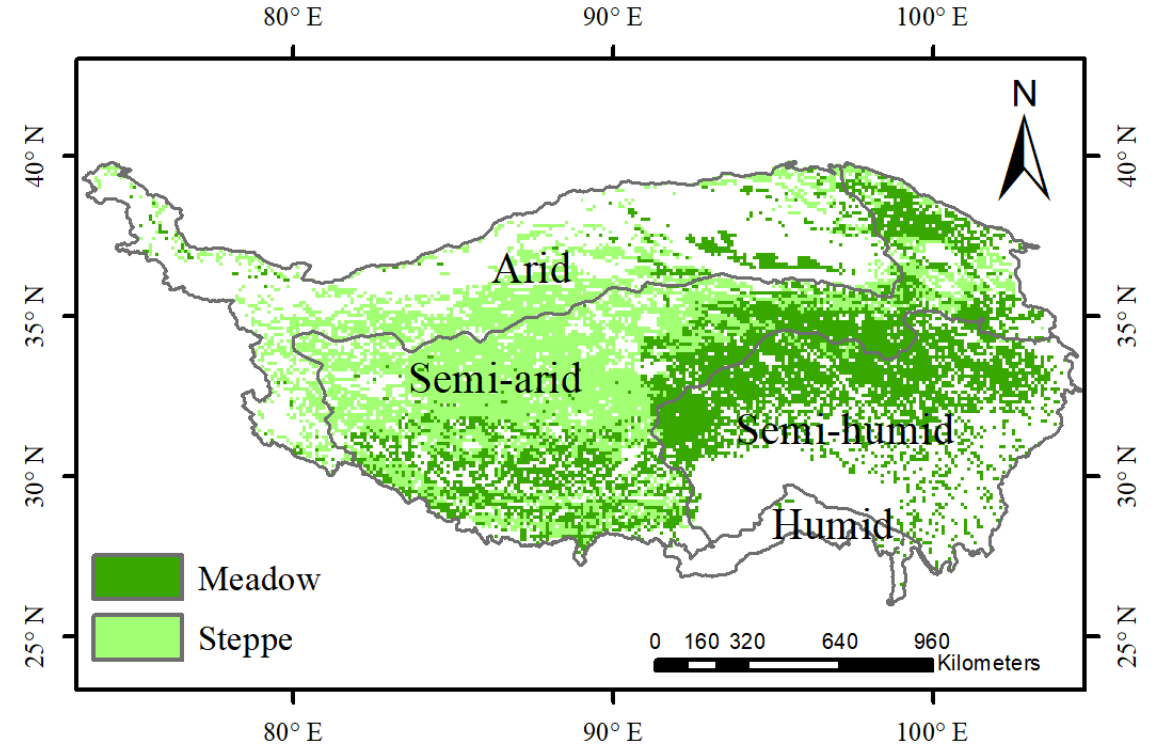
Figure 1. Ecological Geographical Division of Tibetan Plateau and the spatial distribution of alpine meadow and alpine steppe.